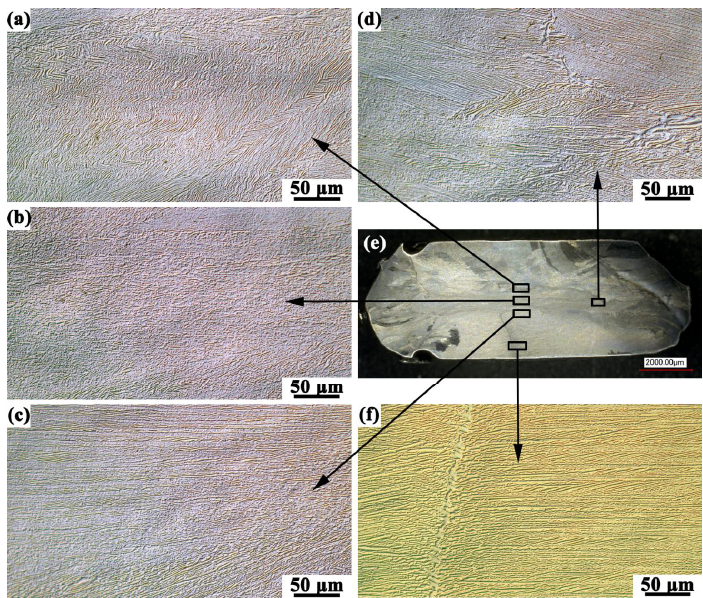
Figure 5. Macro picture of Ti-6Al-4V sample deformed at 900 °C and a strain rate of 10 −2 s −1 . ( a ), ( c ), ( d